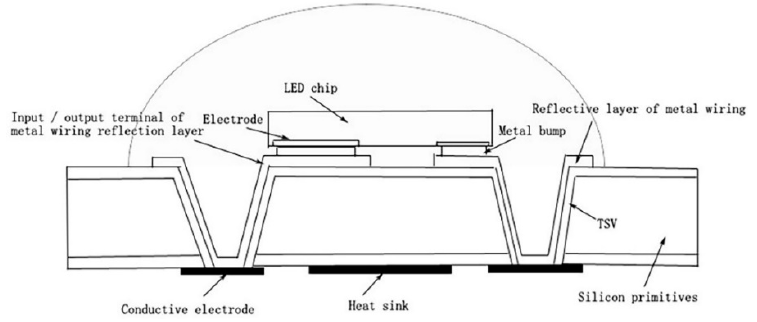
Figure 4. Diagram of a low thermal resistance wafer-level LED package [33].